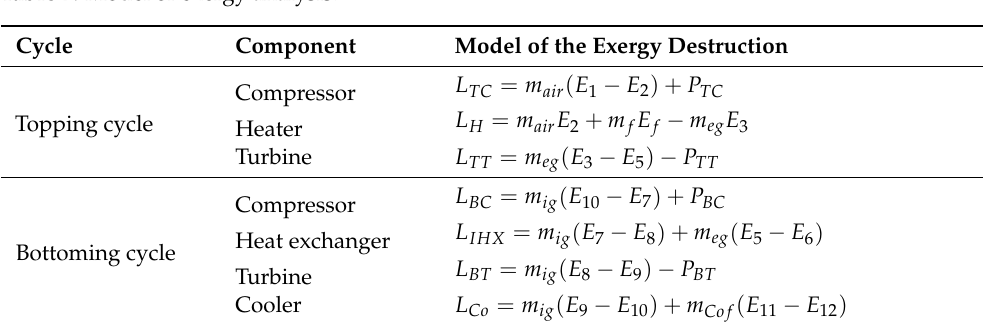
Table 7. Model of exergy